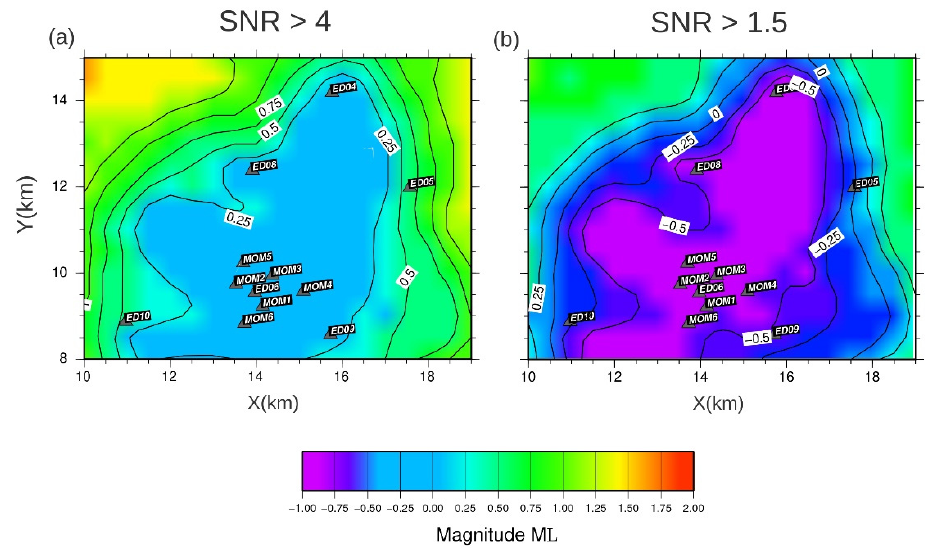
Figure 7. Map of the theoretical minimum detectable magnitude for the array + RSC network configuration considering SNR for the detection at least 4 ( a ) and at least 1.5 ( b ).